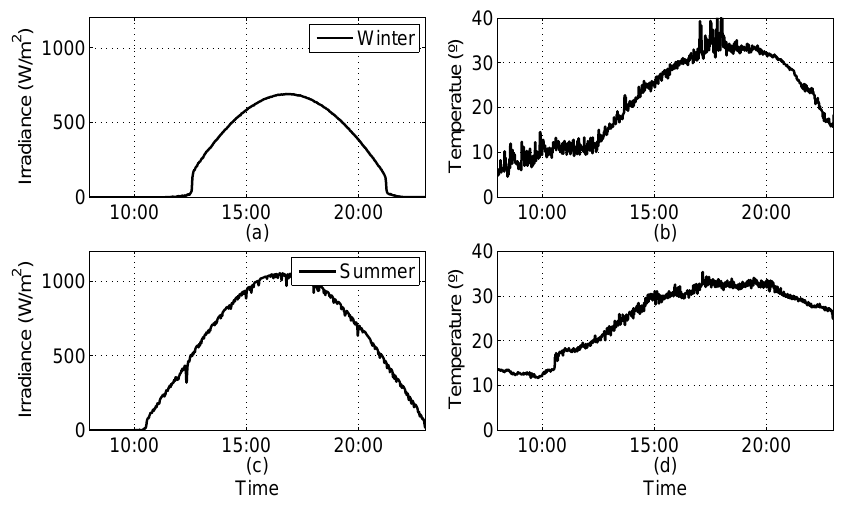
Figure 11. Overall irradiance during a year, showing two seasons: Left side shows an example of the irradiance of one day, and the right side the temperature in the same day.